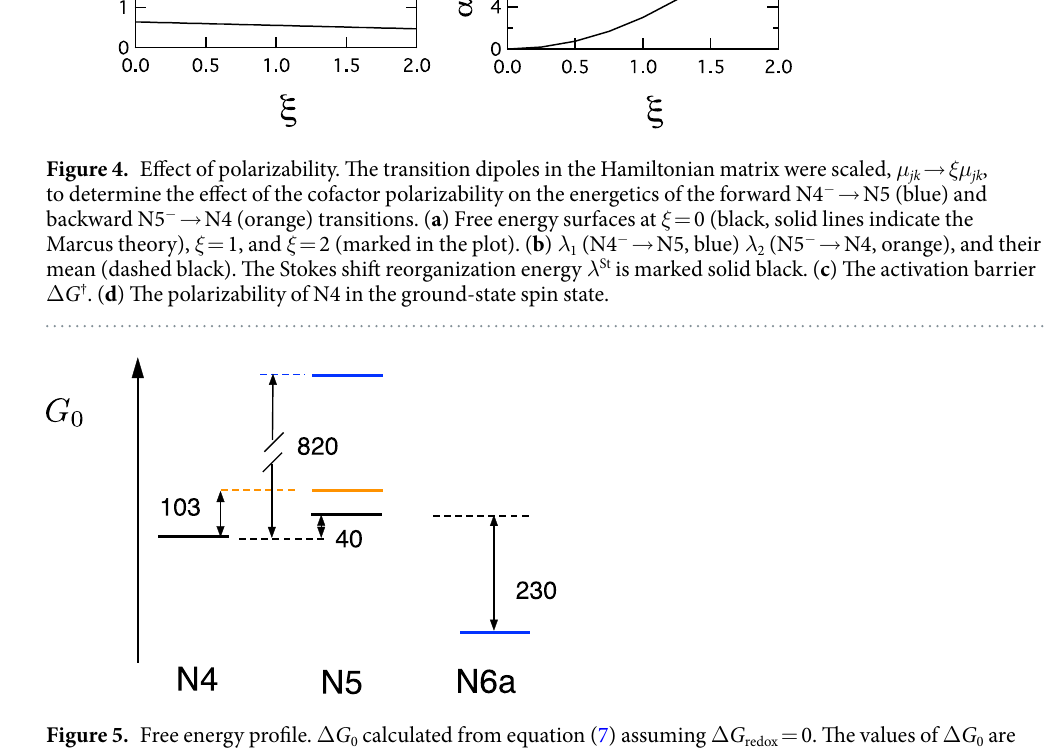
downhill reaction free energy of ∼ 200 meV brings the reaction time down to 4 μ s, thus avoiding kinetic con- straints on the overall performance.